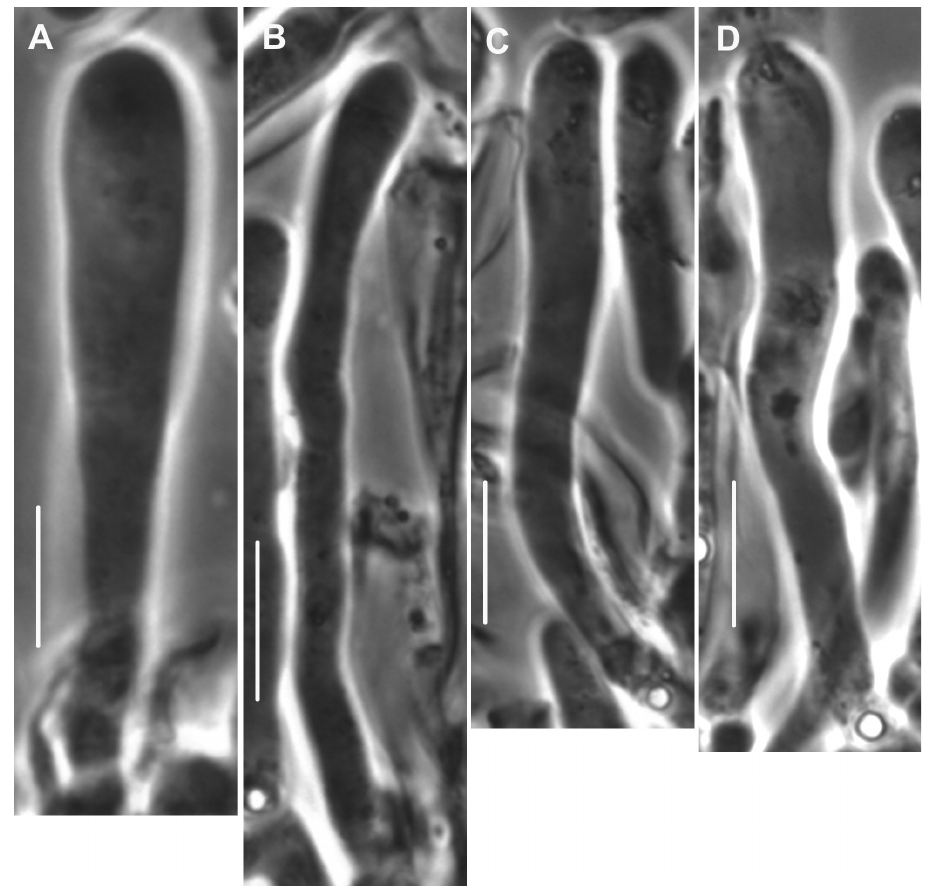
Figure 23. Mycetinis copelandii . A Immature basidium B–D Presumptive pleurocystidia. Standard bars = 10 µm. TFB 8084